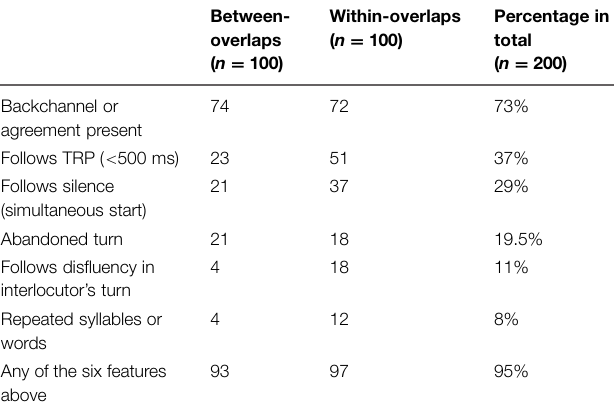
TABLE 2 | Frequency of seven features in a subset of 200 cases of overlap (100 between-overlaps, and 100 within-overlaps) extracted from our Switchboard